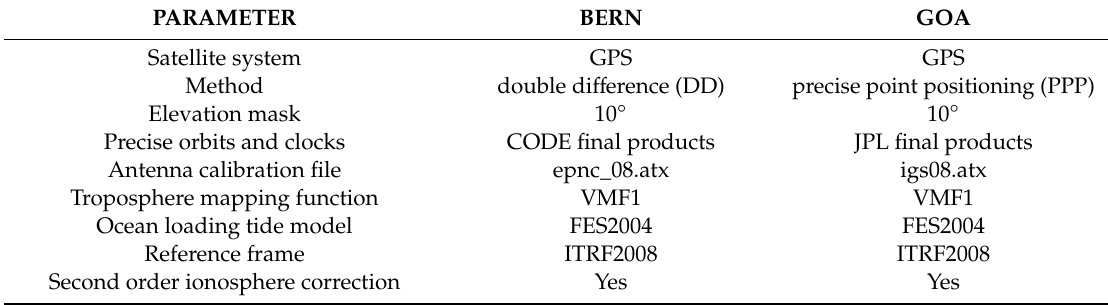
Table 1. Parameters used in coordinate calculation by Gipsy-Oasis II 6.4 (GOA) and Bernese 5.2 (BERN) software. PARAMETER